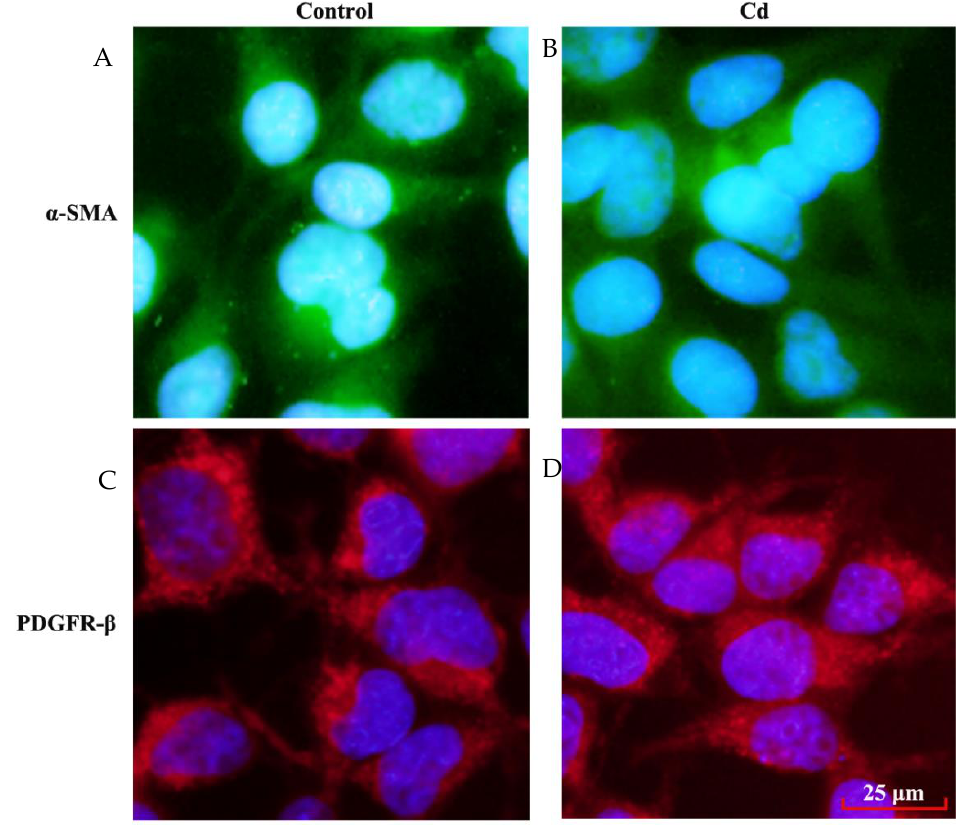
Figure 4. Effects of low dose Cd exposure on α -SMA and PDGFR- β expression in HRMCs. Immunofluoresence staining of α -SMA and PDGFR- β in HRMCsmonolayer treated with PBS (control) and 4 µ M Cd for 24 h. ( A , B ) Representative images of HRMCs with immunofluoresence staining of α -SMA; ( A ) control; ( B ) Cd treatment; ( C , D ) Representative images of HRMCs with immunofluoresence staining of PDGFR- β ; ( C ) control; ( D ) Cd treatment. 3.5. Effects of Low Dose Cd Exposure on the Actin Cytoskeleton of HRMCs